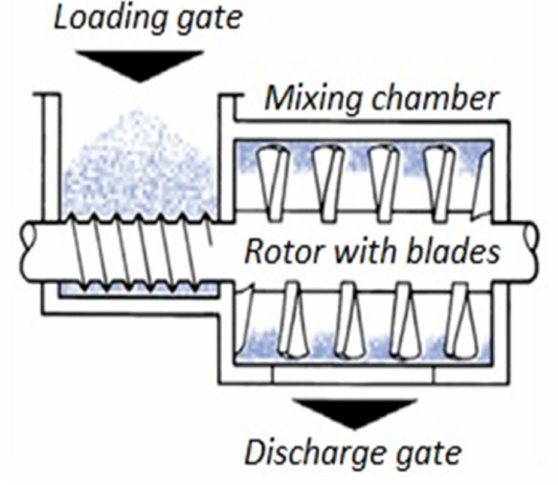
Figure 1. Schematic of GELIMAT ® feeding and mixing chamber